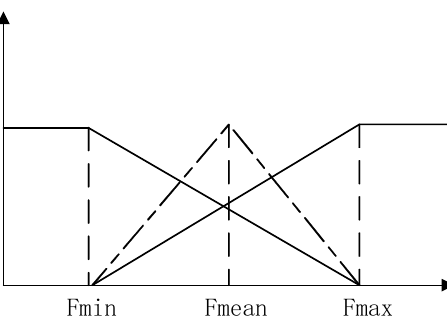
Figure 3. Membership